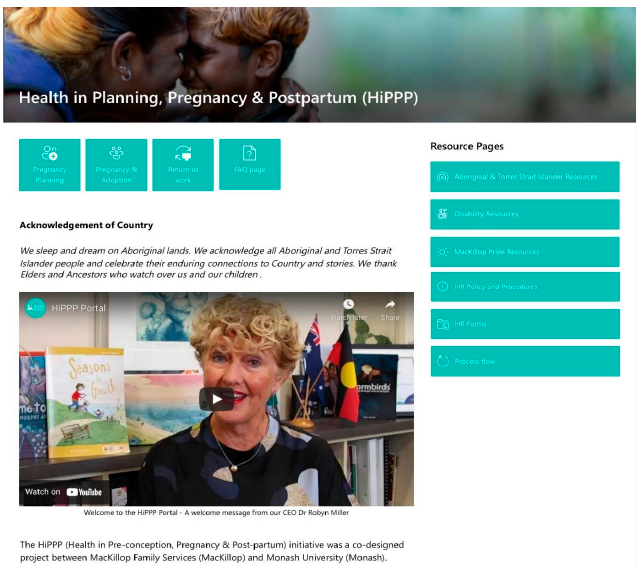
Figure 2. HiPPP Portal example